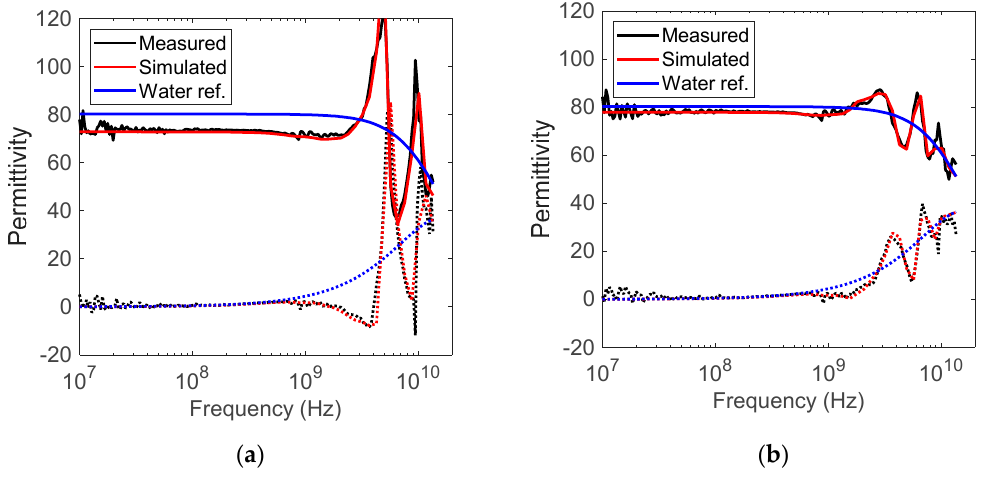
Figure 4. Comparison of measured and simulated relative permittivity spectra for liquid water layers. Liquid water reference spectrum is included. The dielectric constant is plotted with solid lines and the dielectric loss factor with dotted lines. ( a ) 3 mm water layer backed by air ( b ) 5 mm water layer backed by air.